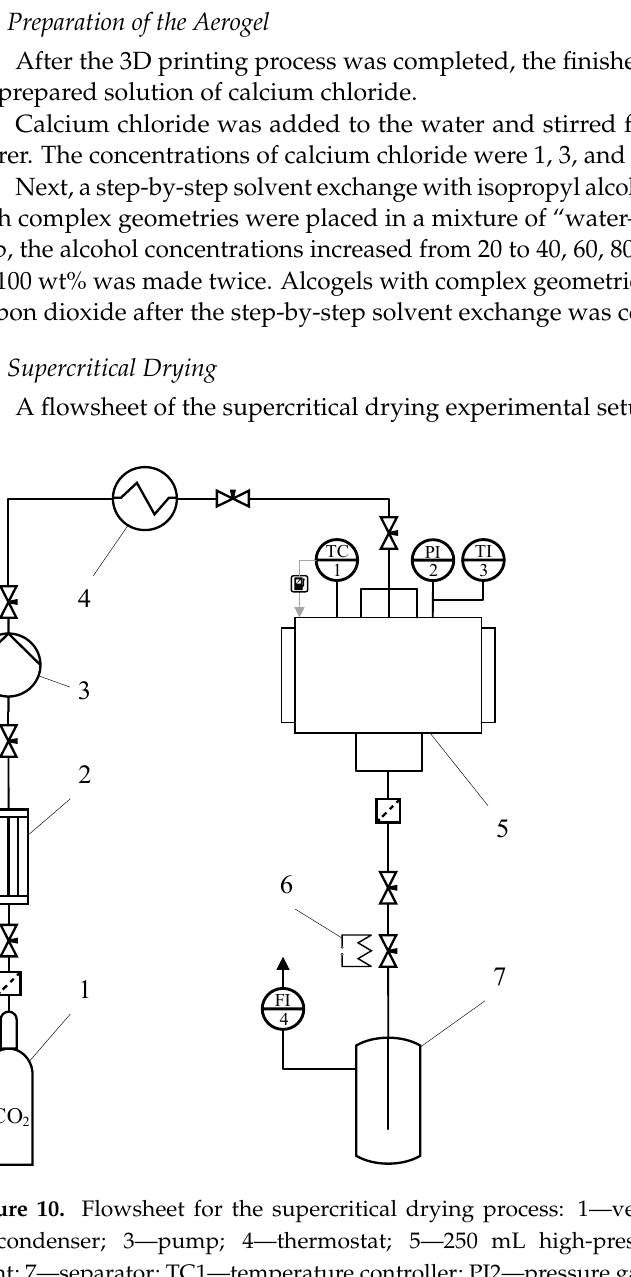
Figure 10. Flowsheet for the supercritical drying process: 1—vessel with liquid CO2 (60 bar); 2—condenser; 3—pump; 4—thermostat; 5—250 mL high-pressure vessels; 6—heating element; 7— separator; TC1—temperature controller; PI2—pressure gauge; TI3—temperature sensor; FI4— rotameter.